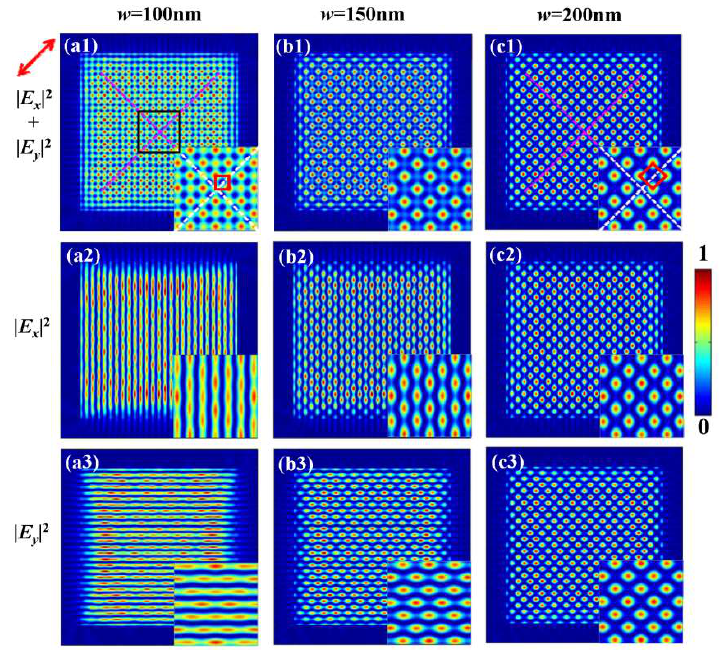
Figure 4. ( a – c ) Normalized theoretical intensity patterns for the square slits with w = 100, 150, 200 nm, respectively. ( a1 – c1 ) are the total intensities . ( a2 – c2 ) are the intensities of the x -polarized patterns . ( a3 – c3 ) are the intensities of the y -polarized patterns . The insets in each image are the enlarged map of the area within the black box. The red arrow represents the polarization direction of the incident light.